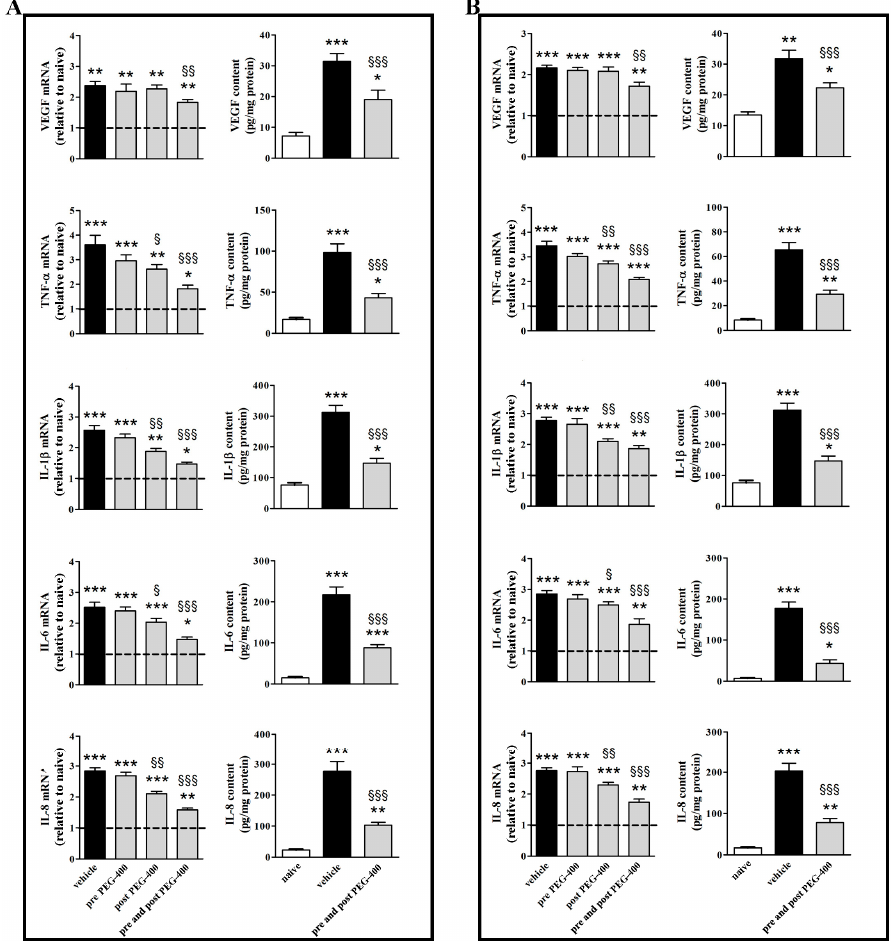
Figure 2. Macular-FAG (mFAG) dietary supplementation reduces PEG-400-induced upregulation of markers of angiogenesis and inflammation in the retina ( A ) or in the RPE/choroid ( B ). Levels were evaluated in mice untreated or subretinally injected with 0.5 mg PEG-400 and receiving vehicle or mFAG for 10 days before PEG-400 injection (pre-PEG-400), for five days after PEG-400 injection (post-PEG-400), or for 10 days before and five days after PEG-400 injection (pre- and post-PEG-400). Transcripts were evaluated by relative quantification with qPCR. Data were analyzed by the formula 2 −ΔΔ CT using Rpl13a as the internal standard. Proteins were evaluated by ELISA (LifeSpan Biosciences, Inc., Seattle, WA, USA). Data were presented as the mean ± S.E.M. ( n = 6/group). * p < 0.05, ** p < 0.01, and *** p < 0.001 versus naive. § p < 0.05, §§ p < 0.01, and §§§ p < 0.001 versus vehicle (one-way ANOVA followed by the Newman-Keuls multiple comparison post-hoc test). Dotted lines, mRNA levels in naive; white bars, naive; black bars, PEG-400-induced mice with vehicle dietary supplementation; grey bars, PEG-400-induced mice with mFAG dietary